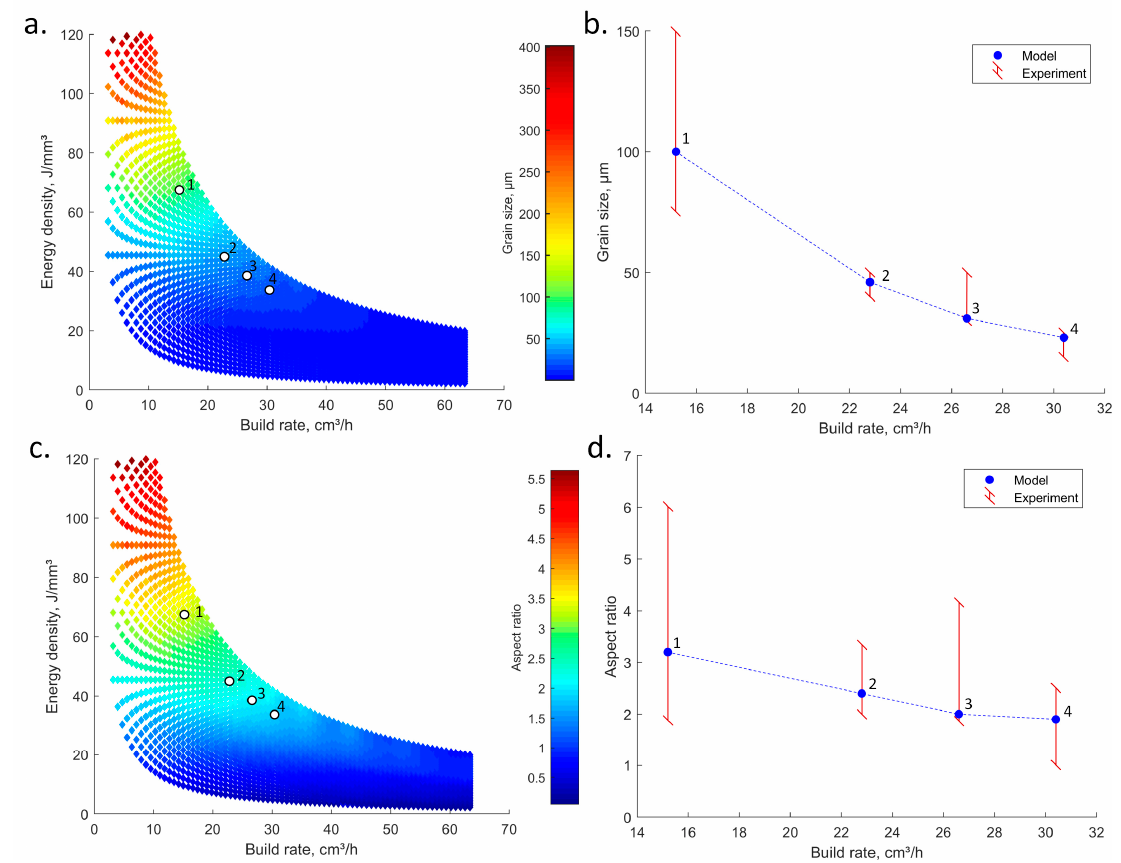
Figure 11. Grain size and grain aspect ratio validation: ( a ) Grain size (dxz) prediction map, ( b ) grain size: model versus experiment [18], ( c ) grain aspect ratio prediction map and ( d ) aspect ratio: model versus experiment; numbers 1 to 4 correspond to four parameter sets tested. Table 6. Grain size (dxz) and grain aspect ratio ( t = 40 μ m; h = 110 μ m): model versus experiment [18].